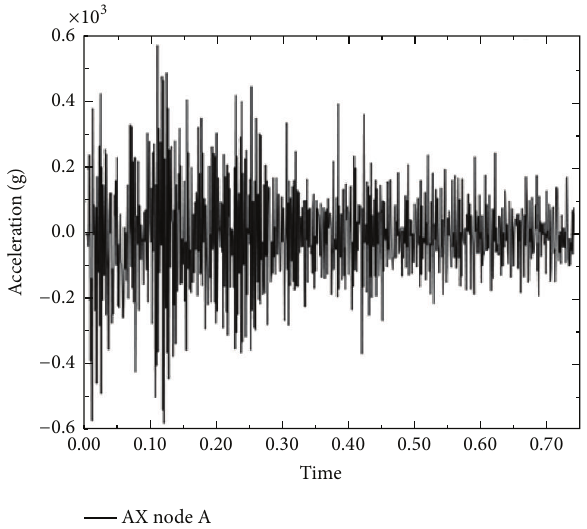
Figure 14: Amplitude of vibration acceleration of collecting plate at the measuring point A obtained from